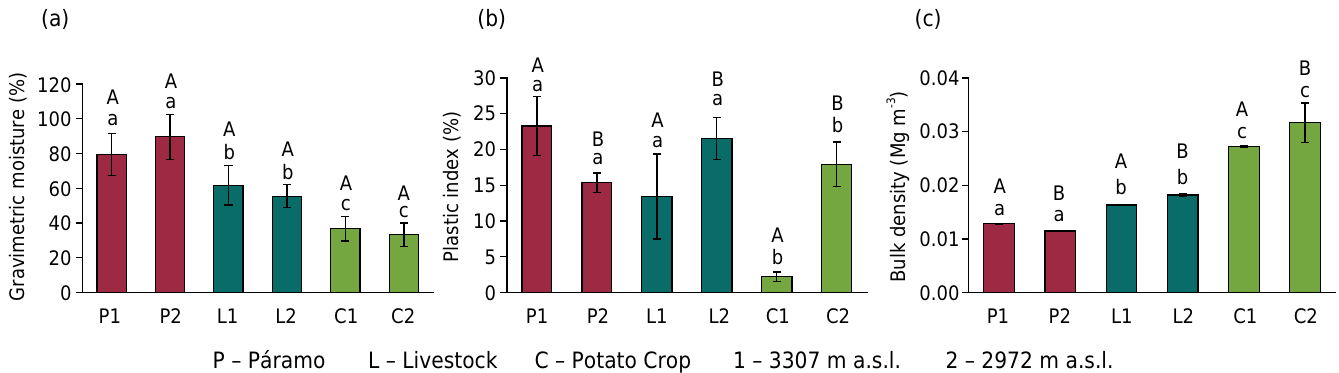
Figure 2. Physical properties of Páramo soils, potato cultivation, and cattle farming: (a) gravimetric moisture; (b) plasticity Index; and (c) bulk density. * Different lowercase letters on the bars represent statistically significant differences between land uses (p≤0.05). ** Different uppercase letters on the bars represent statistically significant differences between heights